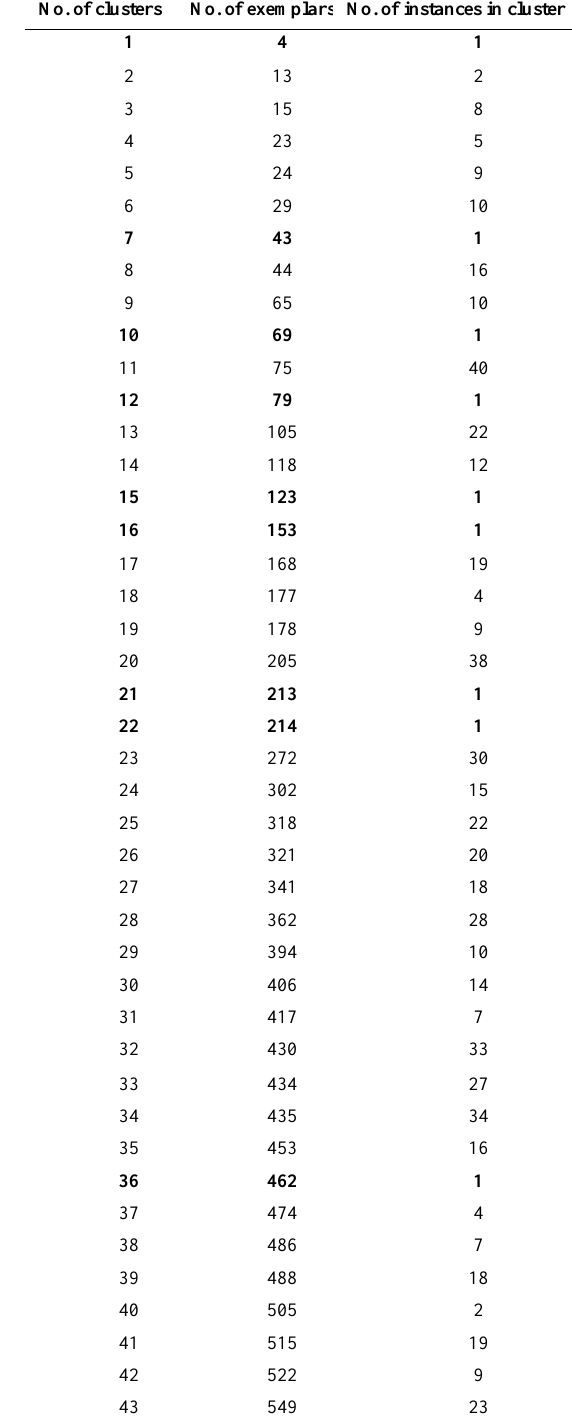
Table 3. Results of AP clustering on